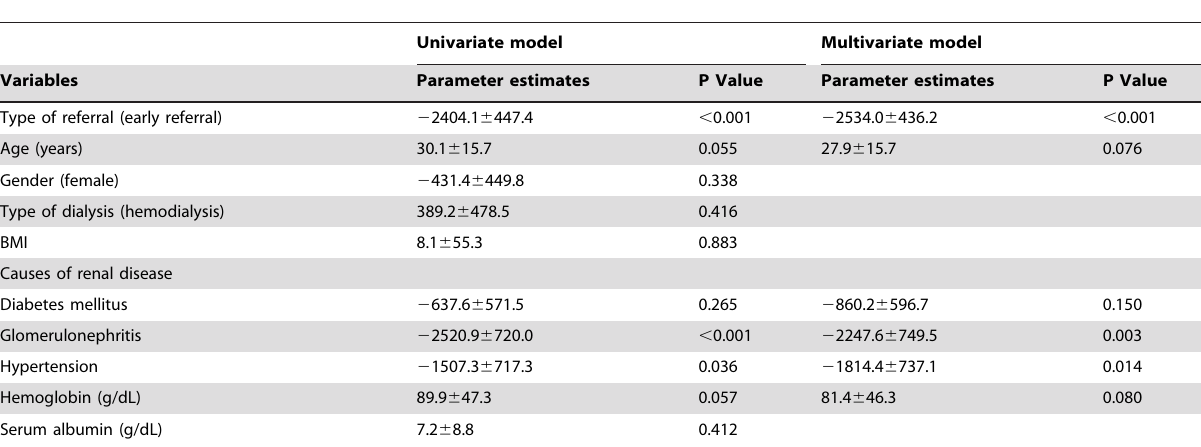
Table 4. Multivariate analysis for medical costs during the 1 year before dialysis